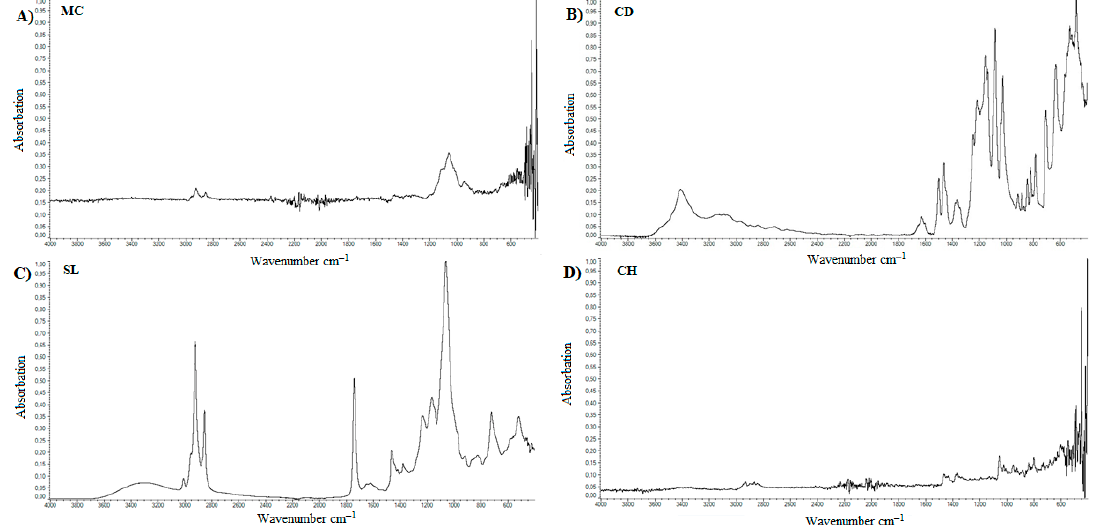
Figure 7. FTIR spectrum for standards. ( A ) methylcellulose; ( B ) calcium dobesilate; ( C ) soy lecithin; ( D ) cholesterol.